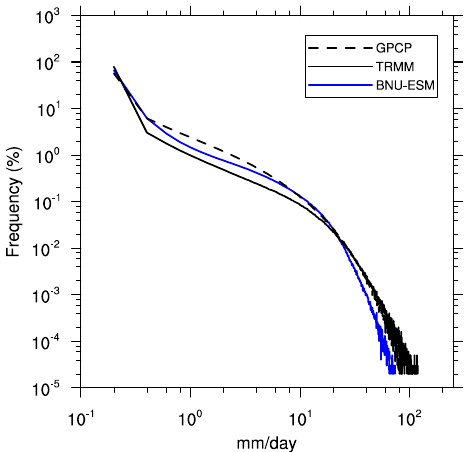
Figure 10. Frequency (%) of daily precipitation rate over land between 20 ◦ N and 20 ◦ S from BNU-ESM historical simulation over the period 1990–1999, the GPCP 1-degree daily data set and TRMM 3B42 daily observations over the period 1999–2008. All data are regridded to the T42 spectral resolution (approximately 2.81 ◦ × 2.81 ◦ transform